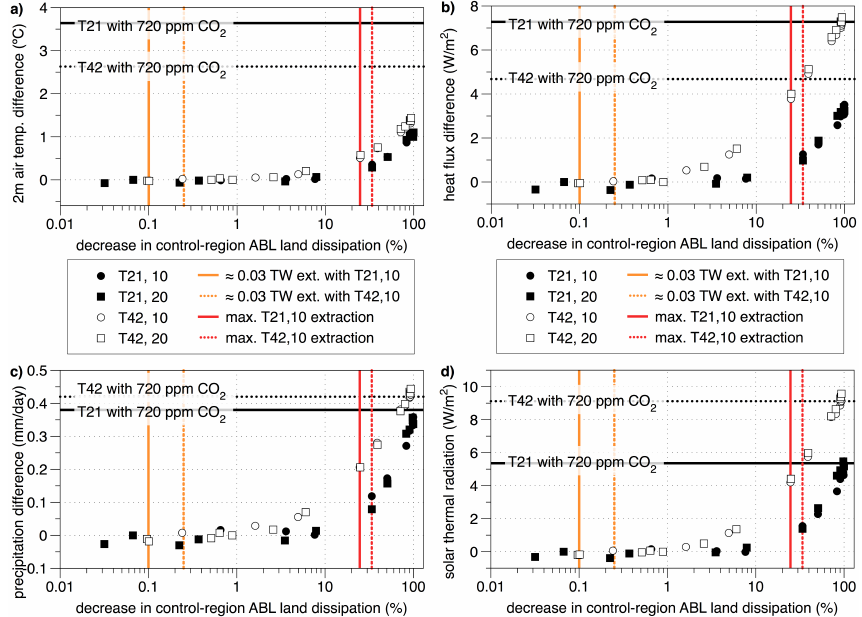
Fig. 7. A simulated sensitivity analysis showing absolute differences in climatic variables over all non-glaciated land for (a) 2-m air tem- perature, (b) sensible+latent heat flux, (c) precipitation, and (d) surface thermal radiation, resulting from increasing land-based wind power extraction compared to the respective model configuration control simulation. For comparison, simulations with an atmospheric CO 2 concen- tration of 720ppm are shown for a T21 simulation with 10 vertical levels (horizontal solid black line) and a T42 simulation with 10 vertical levels (horizontal dashed black line). For reference, the maximum wind power extraction (vertical red lines) and estimated 0.03TW of electricity production in 2008 (World Wind Energy Association, 2008) from the general circulation model configurations (vertical orange lines) is also shown. The climatic differences are shown in relation to the decrease in control-region atmospheric boundary layer (ABL) land dissipation estimated by the respective model configuration. (34 TW) of the control simulation total atmospheric dissipa- tion rate of 1064 TW can be extracted as mechanical power from the control-region atmospheric boundary layer. Dif- ferent model configurations do result in different dissipation rates. Assuming climatic steady-state, this difference in the dissipation rate also shows a difference in the modeled gener- ation rate. Still, by relating the total atmospheric dissipation rate to extractable mechanical power, these estimates only vary by ≈ 1%. A different general circulation model will certainly result in slightly different estimates, yet there is no obvious reason why other models should yield substantially different estimates in both maximized power extraction and the associated climatic consequences.